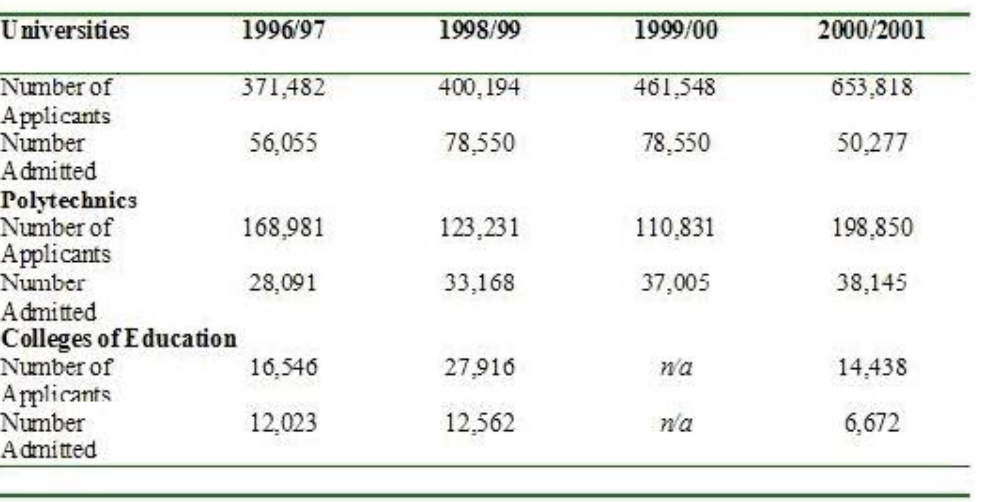
Table 1. Number of applicants and number of students admitted to higher education programs